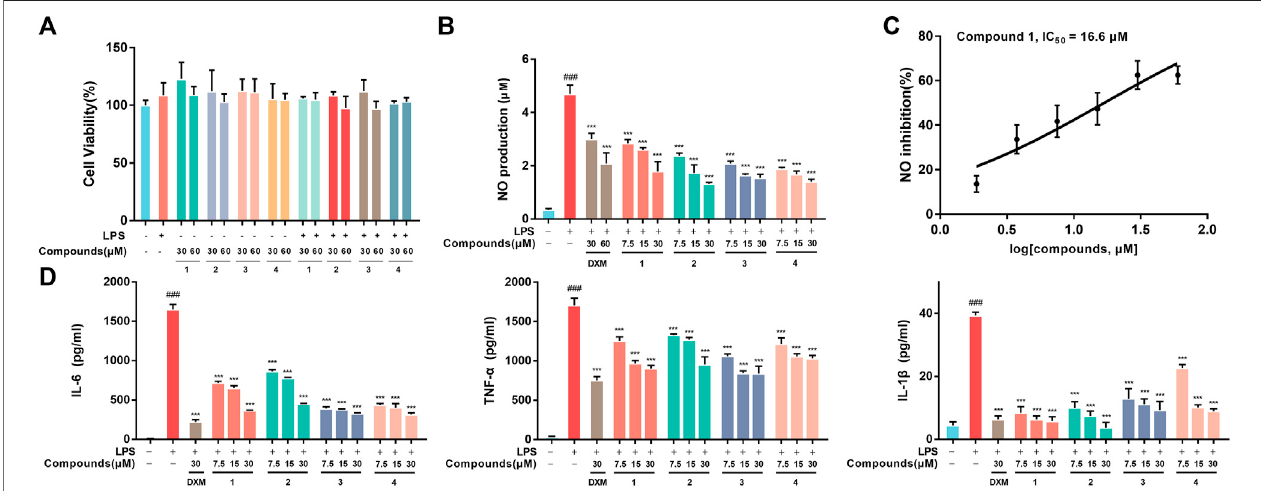
FIGURE2|(A) Cellviability. RAW264.7 macrophagesweretreatedwithDMSO, LPS,compounds-30 μ M, compounds-60 μ M, LPS+compounds-30 μ M, LPS+ compounds-60 μ M for 24 h, respectively. (B) Inhibition of LPS-induced NO production by 1-4 in LPS-stimulated RAW264.7 macrophages. (C) The IC 50 value of compound 1 against LPS-stimulated NO production in RAW264.7 macrophages. (D) Inhibition of LPS-stimulated TNF- α , IL-6 and IL-1 β production in LPS-stimulated RAW264.7 macrophages. Data are expressed as the mean ± SD. ### p < 0.001, compared with the normal control group. *** p < 0.001, compared with the LPS group.